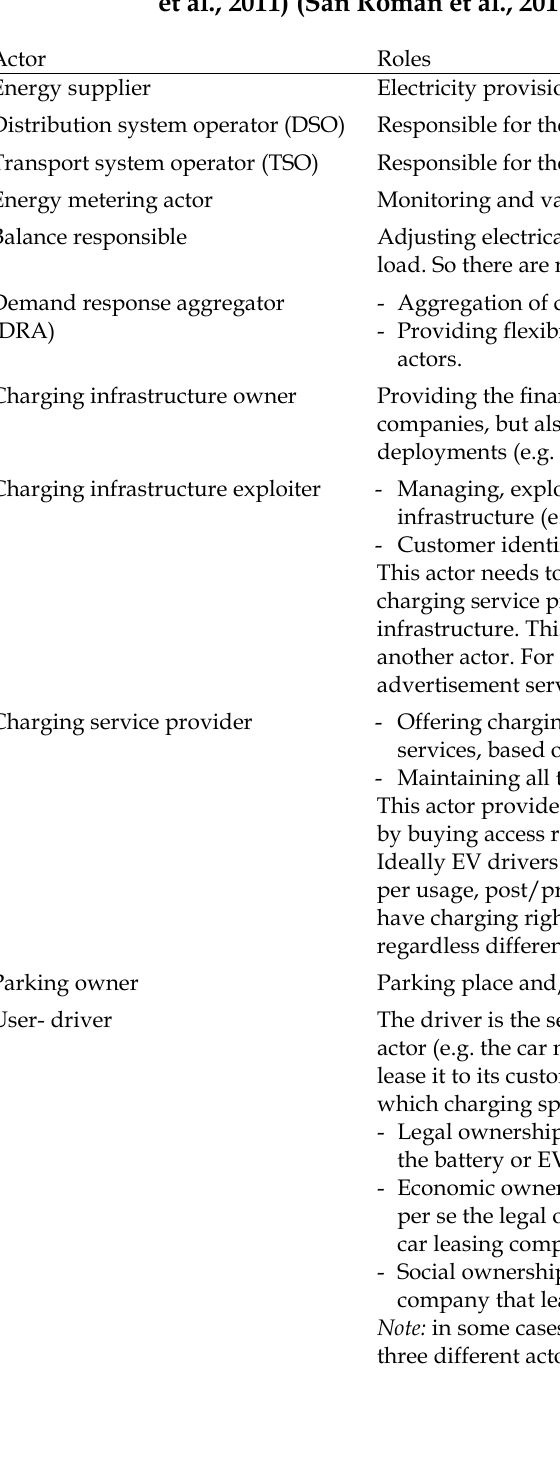
Table 2. Overview of actors and their roles in the market model (Accenture, 2010) (Kley et al., 2011) (San Román et al., 2011) (Bolczek et al.,